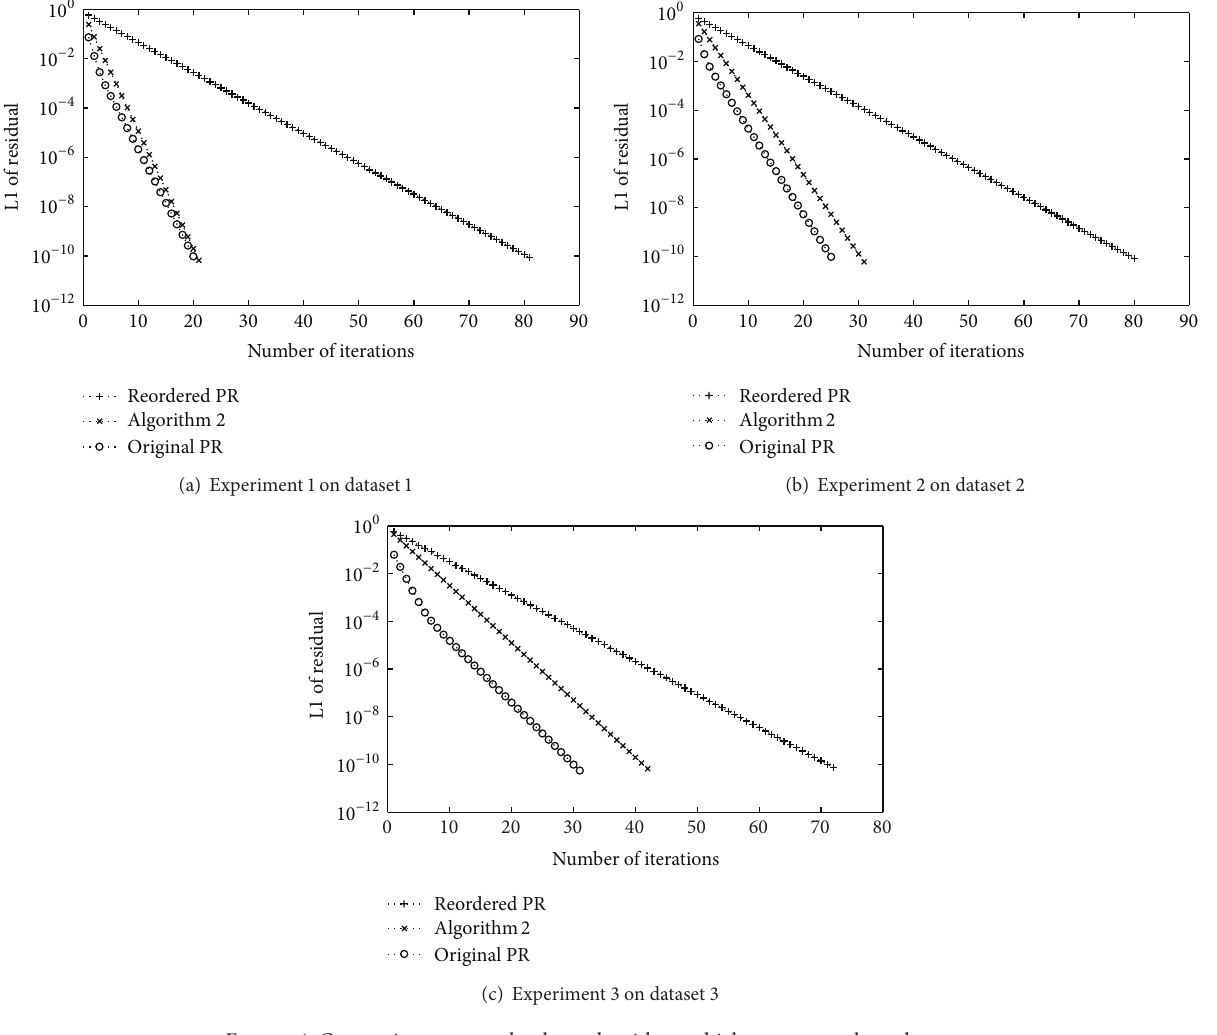
Figure 4: Comparison among the three algorithms which are run on three datasets. Table 1: Comparison of original PageRank, reordered PageRank and Algorithm